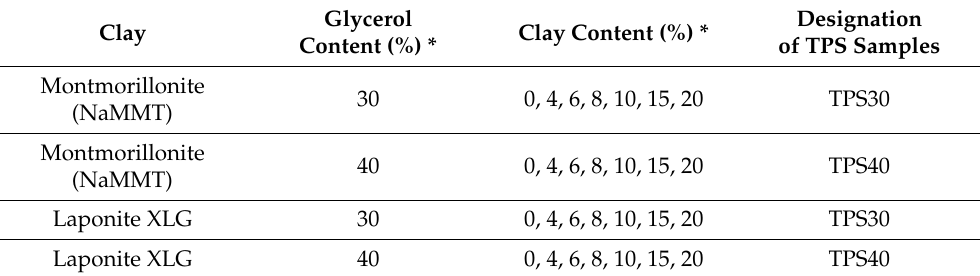
Table 2. Composition and designation of the TPS